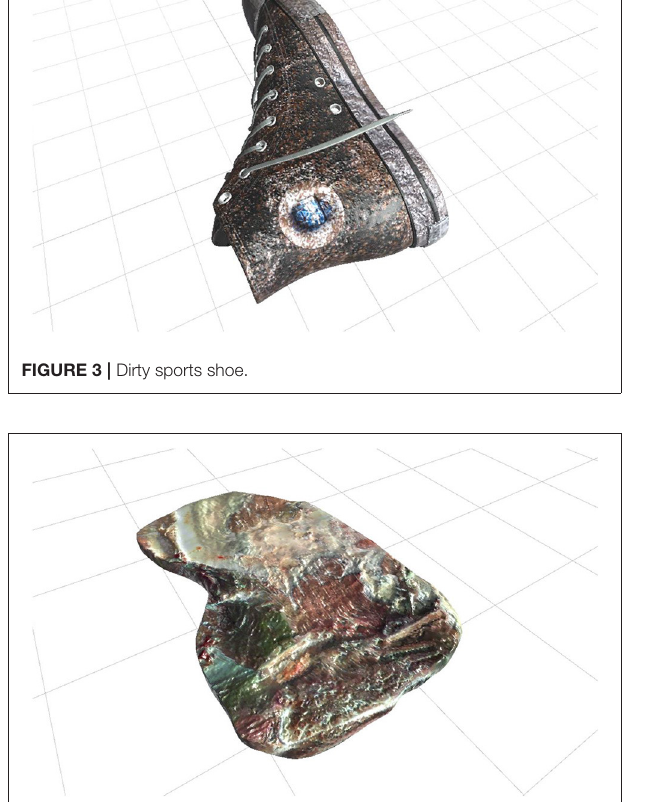
FIGURE 4 | Rotten meat.